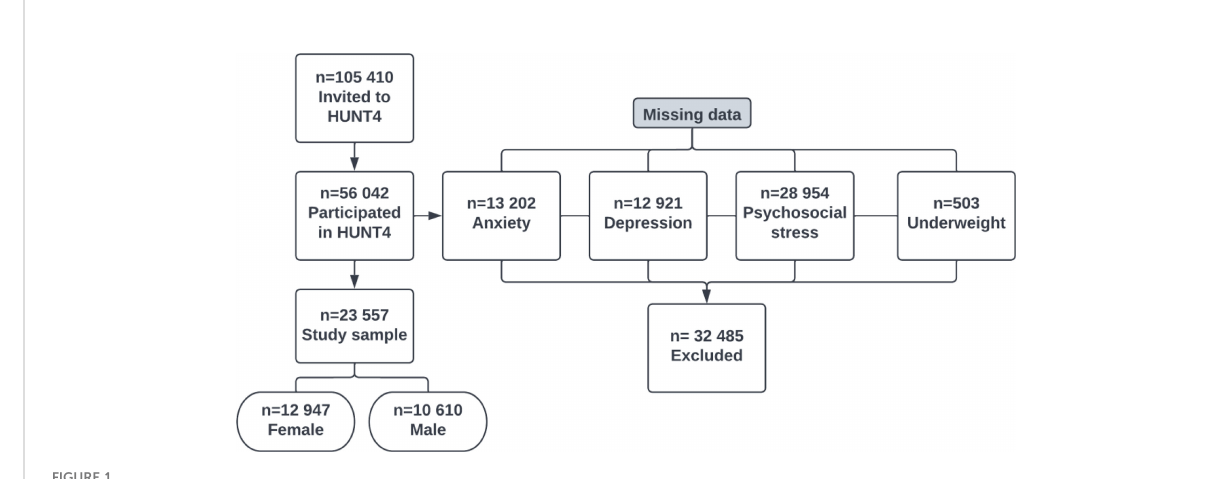
FIGURE 1 Flowchart of the study